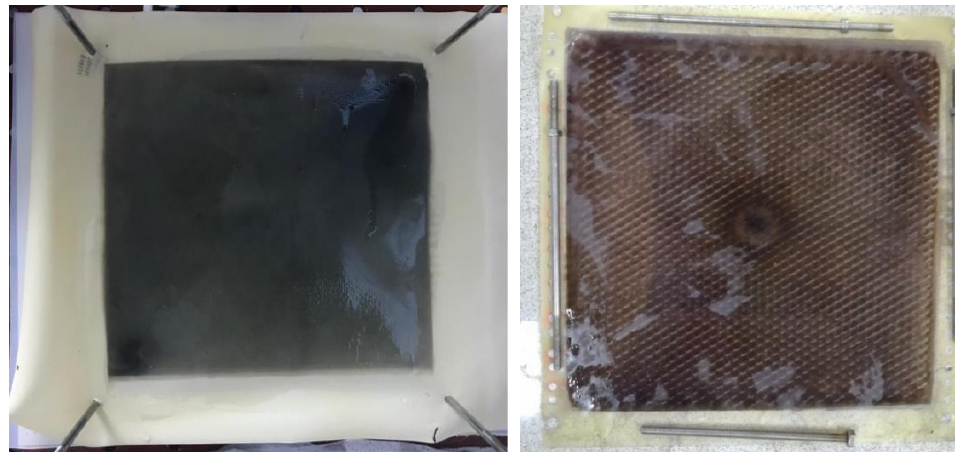
Figure 8. The images of the anion exchange membranes after treatment of textile wastewater without color removal process.